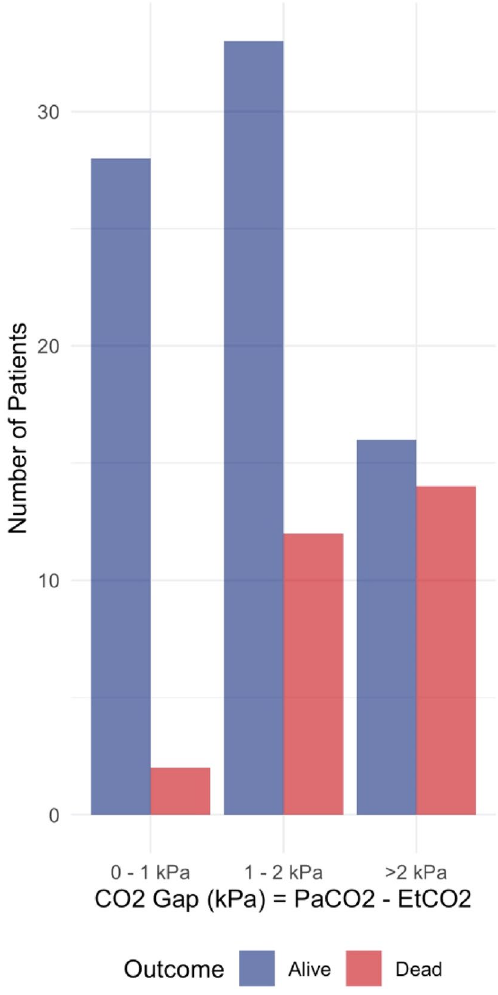
Figure 3. Bar diagram showing survival for CO2 gap groups. Bar diagram showing outcome by groups of CO2 gap measured initially. Figure was created using RStudio (2020). RStudio: integrated development for R. RStudio, PBC, Boston, MA URL http:// www. rstud io. com/ and the package ggplot2 by Wickham H